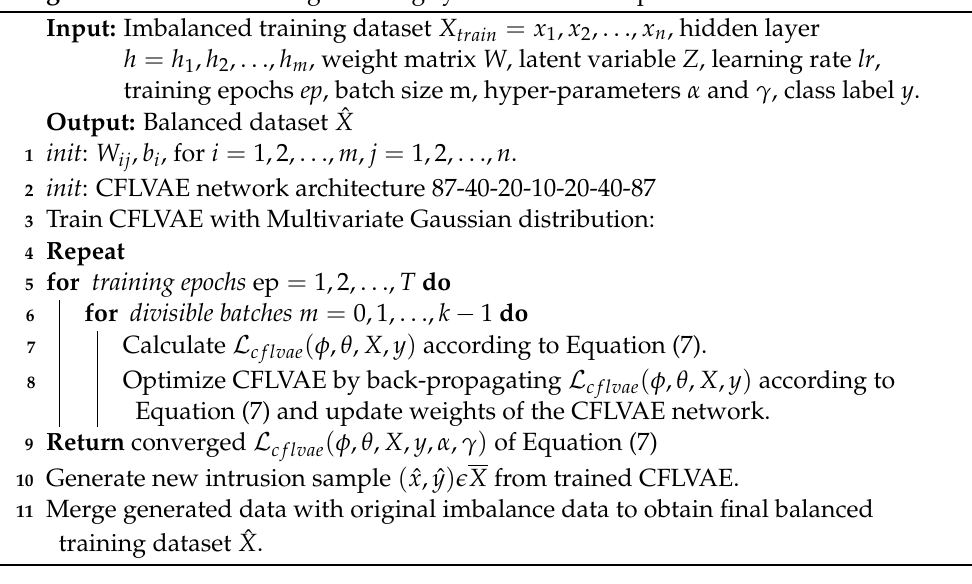
Algorithm 2: CFLVAE for generating synthetic data